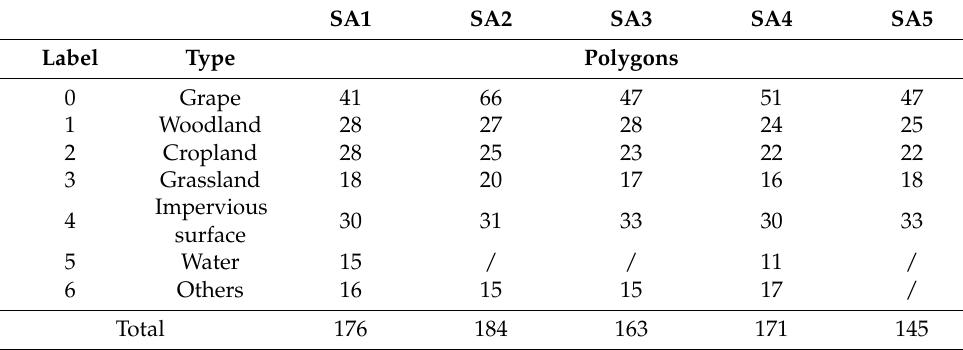
Table 4. Sample size of grapes and other land cover types used in this study.